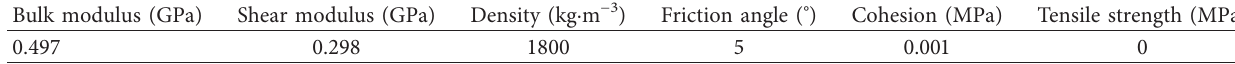
Table 3: Numerical simulation parameters of the compacted rock mass in the gob.